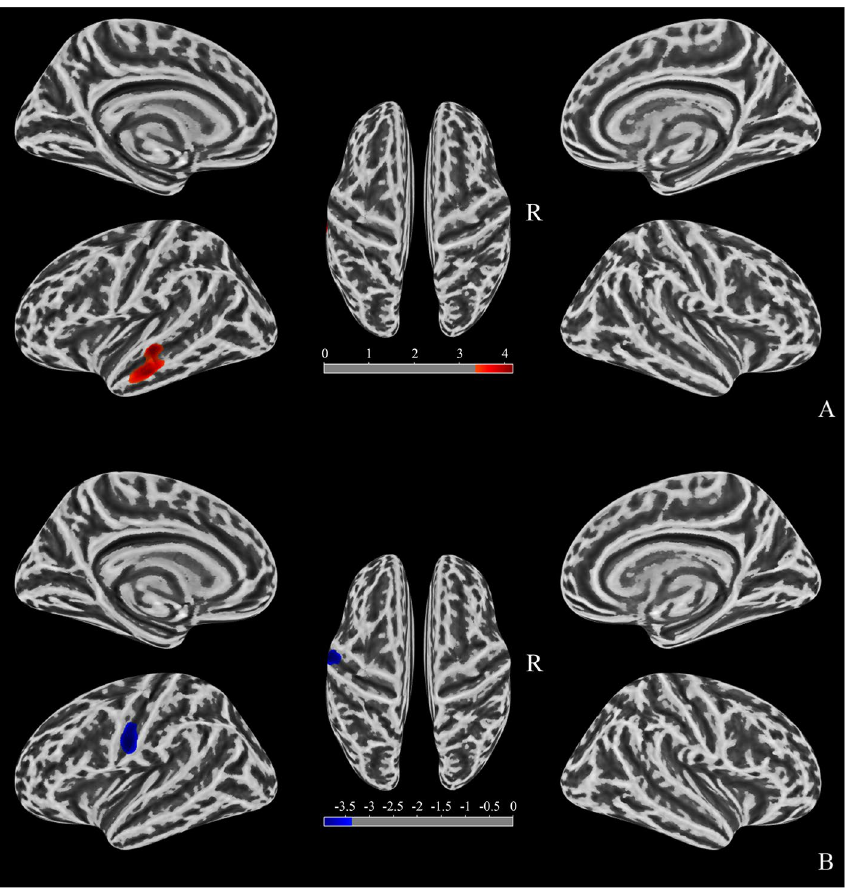
Fig. 5 A comparison of the cortical morphology of patients with CTN and healthy controls using SBM. ( A ) Gyrification: red clusters representing significantly more gyrification (left middle temporal gyrus) in patients with CTN (FWE, voxels P < 0.001, clusters P < 0.05). ( B ) Cortical thickness: blue clusters representing significantly thinner cortical regions (left postcentral) in patients with CTN (FWE, voxels P < 0.001, clusters P < 0.05). CTN, classical trigeminal neuralgia; SBM, surface-based morphometry; FWE, family-wise